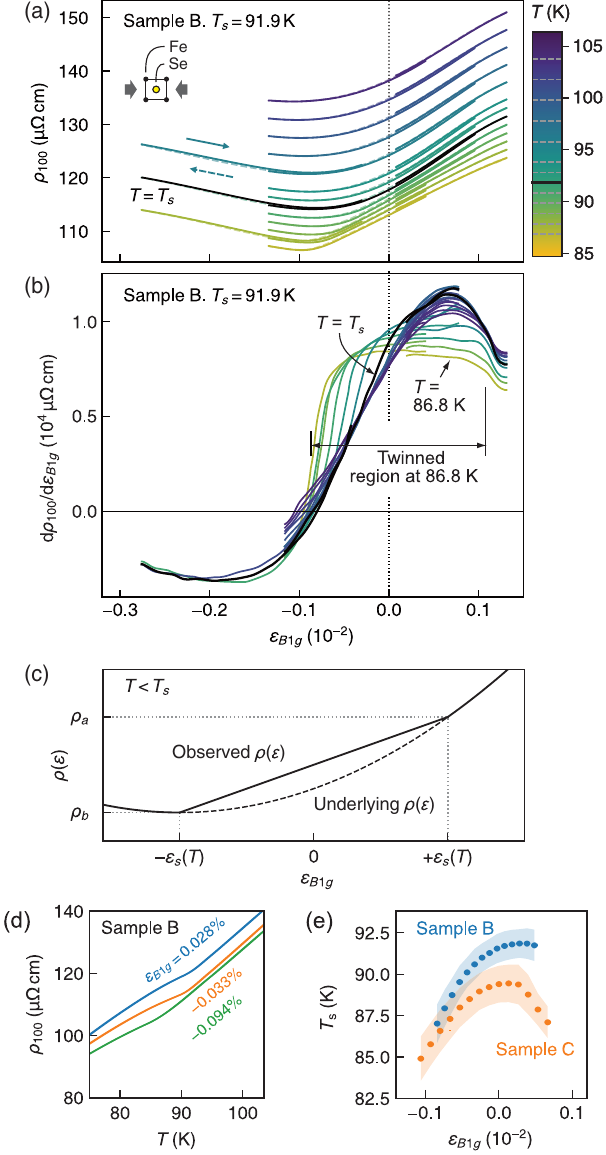
Þ , where ρ . (a) ρ 100 ð ε 100 is s B 1 g ≡ ð ε − ε Þ = 2 , 100 010 B 1 g . (b) d ρ 100 =d ε for s B 1 g , d ρ 100 =d ε becomes nearly s B 1 g Þ for B 1 g < ε < þ ε s B 1 g s